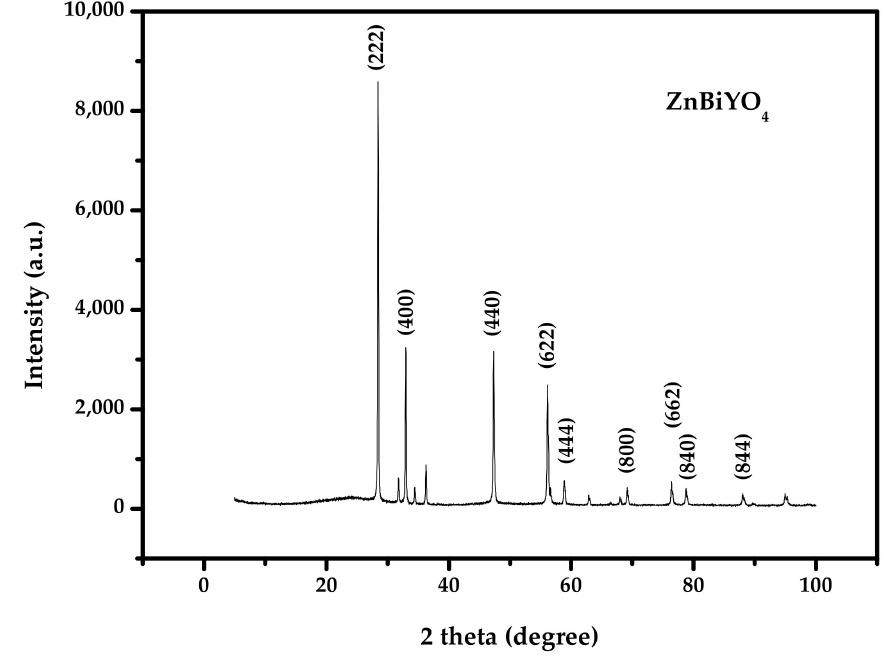
Figure 2. The XRD spectrum of ZnBiYO 4